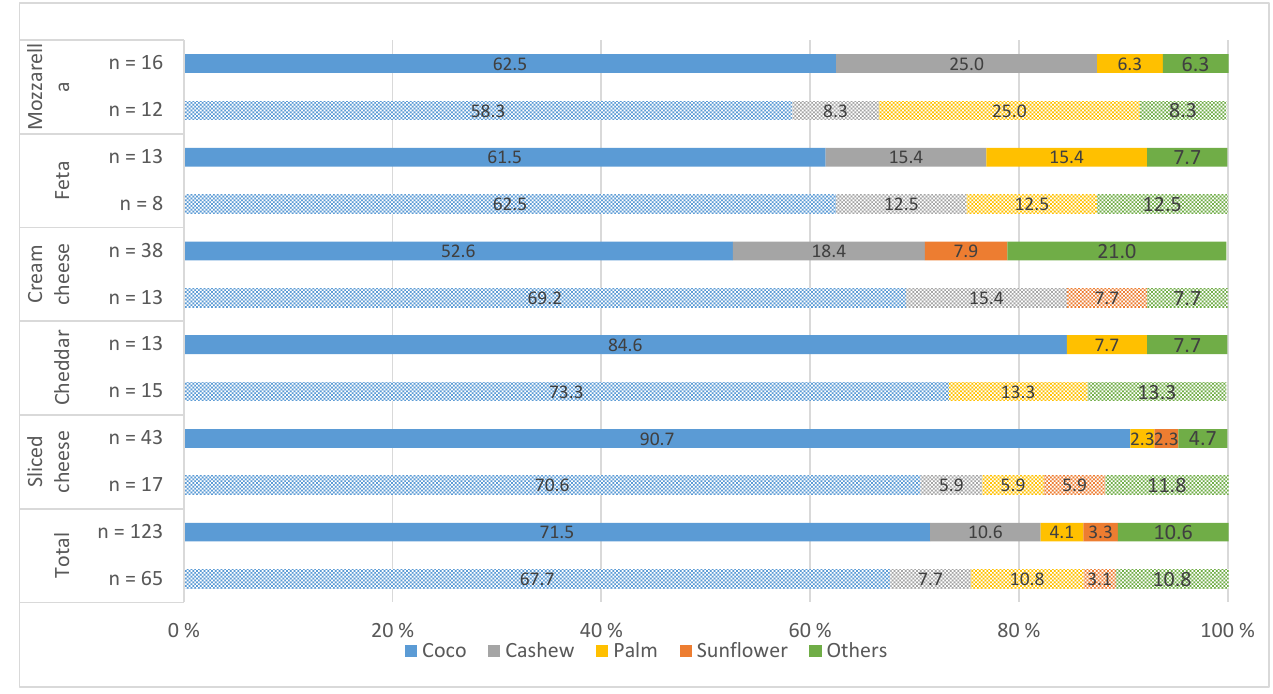
Figure 3. Fat sources used in plant-based cheese alternatives (PBCA) in 2019 (patterned color) and 2021 (solid color) (%); n = number of products; others = almond, shea butter, soy, olive, lupine.